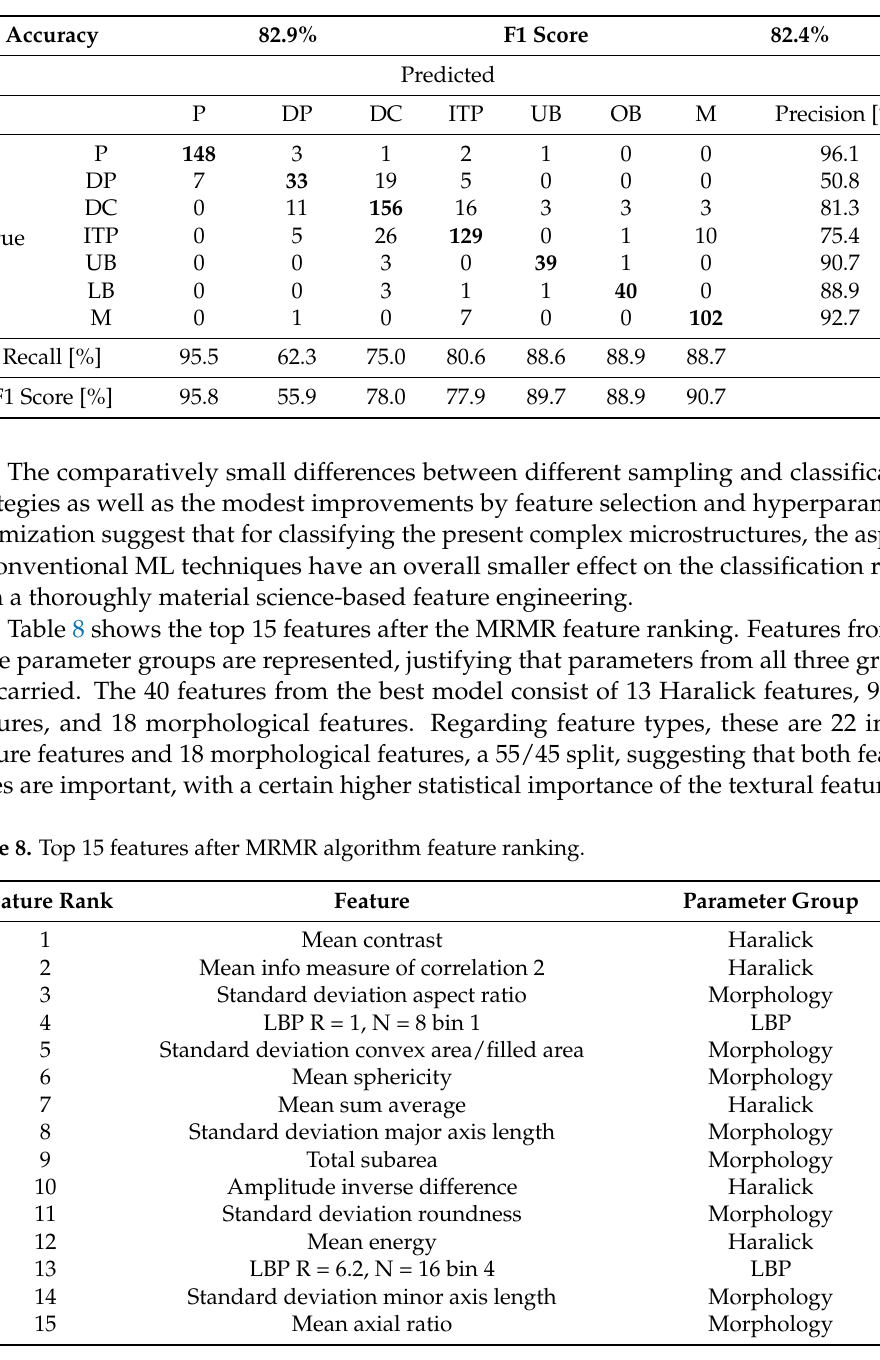
Table 7. Confusion matrix of the best classification model (reduction to 40 features and hyperparam- eter optimization).